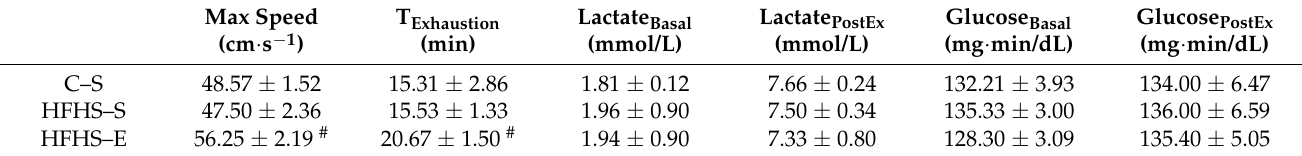
Table 2. Maximal workload test.